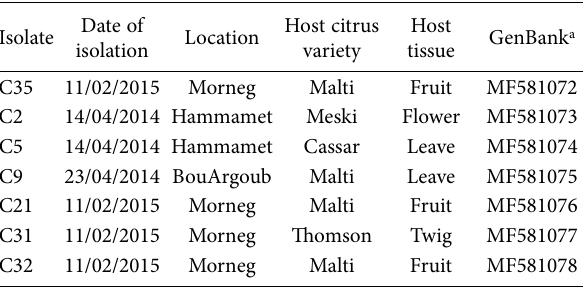
Table1. Characteristics of Colletotrichum species used in this study.